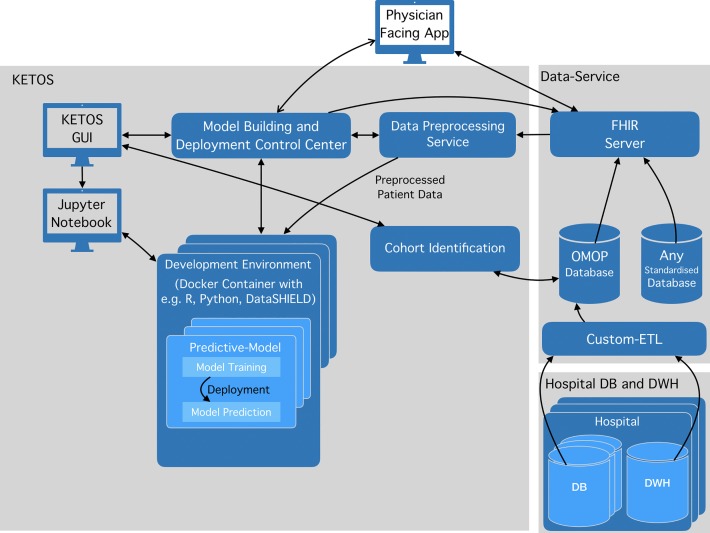
KETOS architecture.